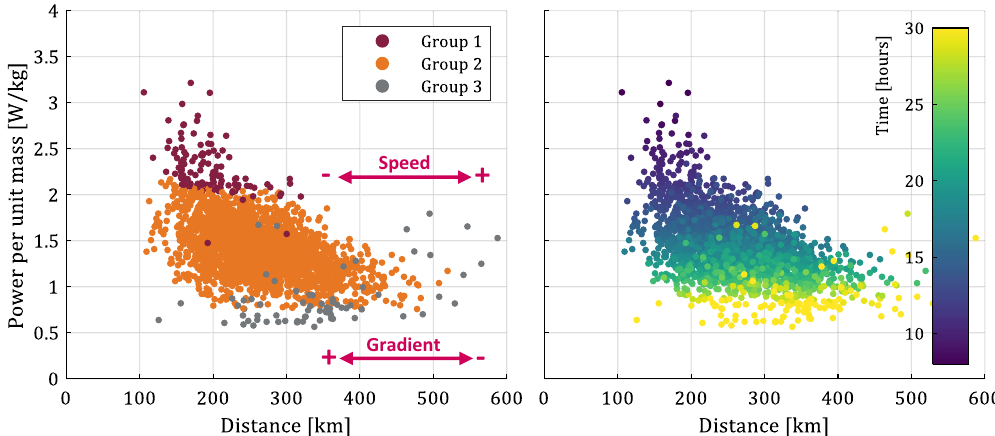
Figure 4. Estimated power per unit body mass versus distance, indicating different clusters of cyclists (groups 1, 2, and 3), and indicating the time to complete the Everesting